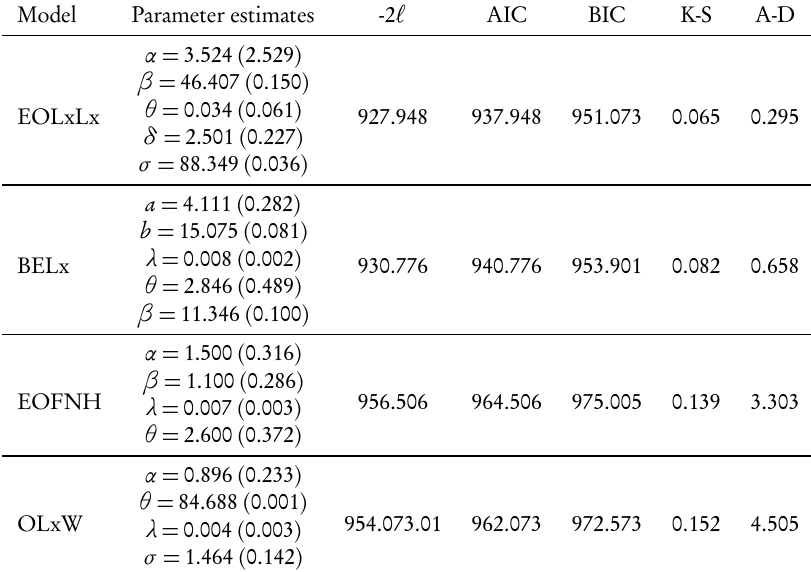
Model comparison for fatigue life of 6061-T6 aluminum coupons data.